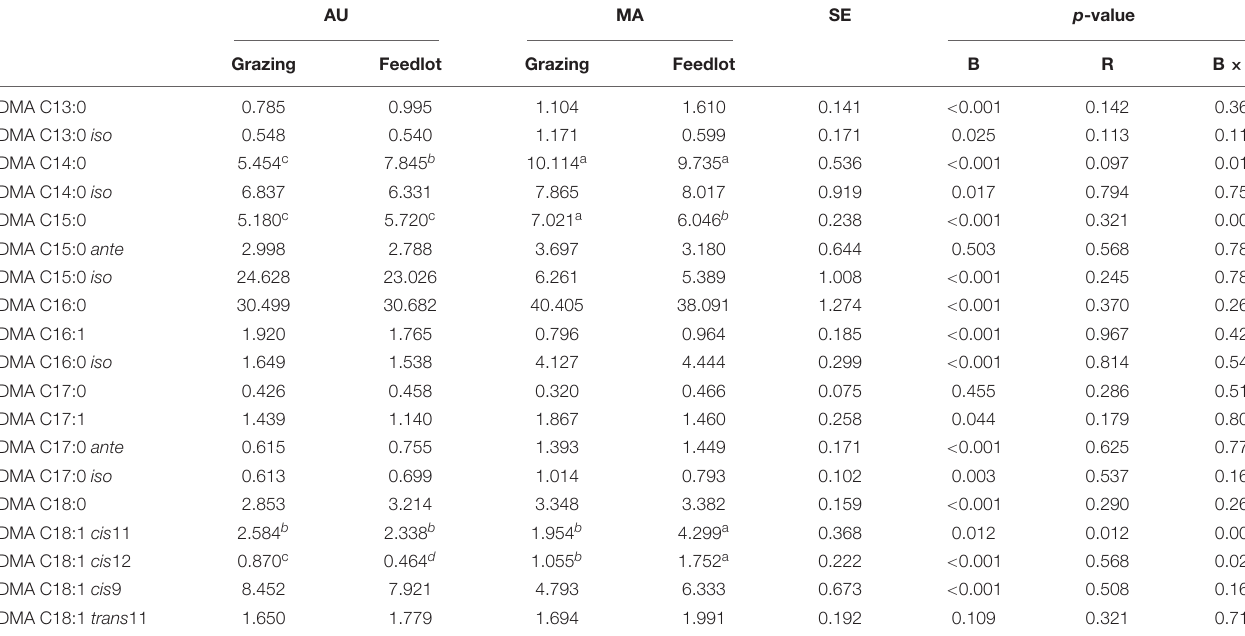
TABLE 3 | Relative percentage of dimethyl acetals (g/100 g of total DMAs) in the rumen liquor from Aubrac or Maremmana steers maintained in feedlot or on pasture. AU MA SE p -value Grazing Feedlot Grazing Feedlot B R B × R